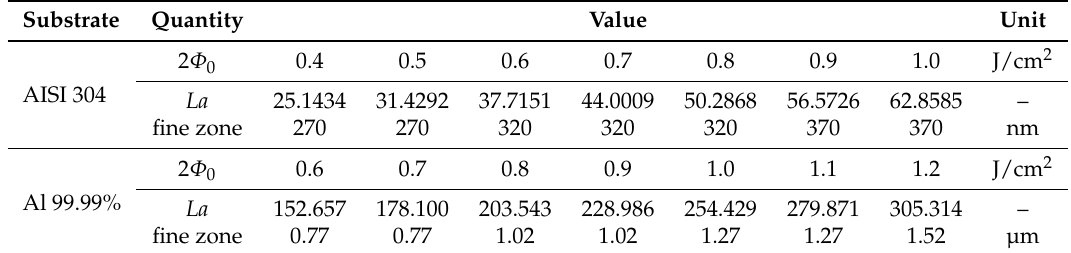
Table 5. Range of the processing parameter fluence investigated for metallic substrates, complemented by specification of corresponding Laser number and finely discretised near-surface zone